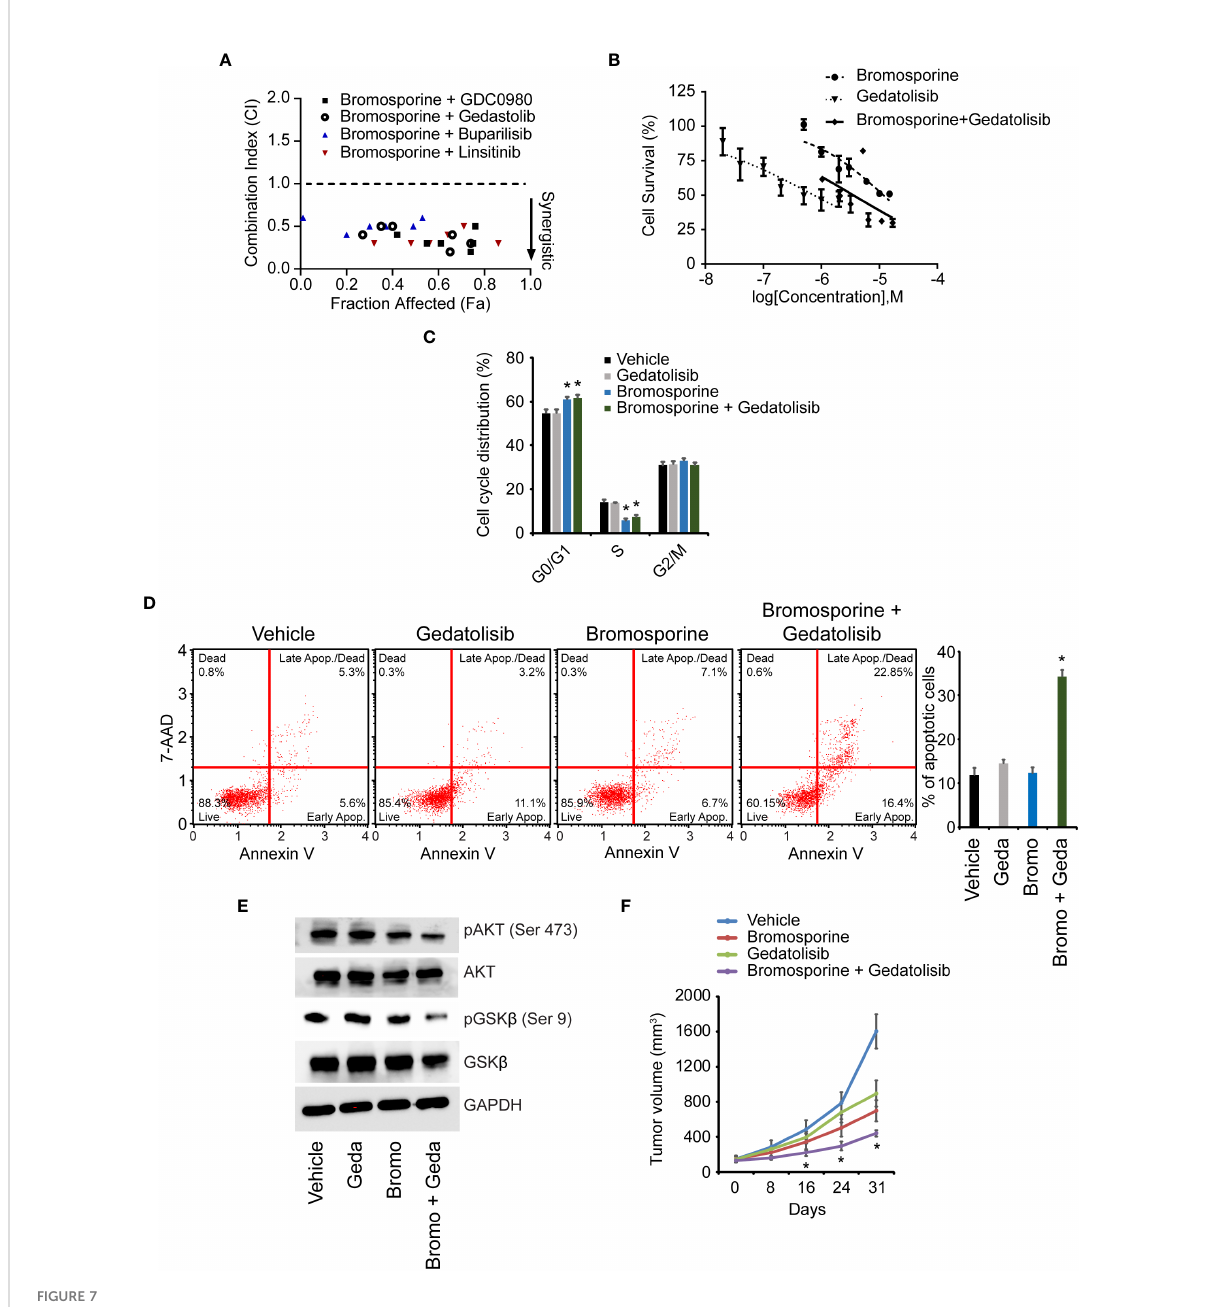
FIGURE 7 Effects of combinatorial therapy with bromosporine and PI3K pathway-targeting agents. (A) Combination index (CI) values for various bromosporine-containing combinations in 231 cells. (B) Effects of treatment with bromosporine and gedatolisib, alone or in combination, on viability of 231 cells. (C) Cell cycle analysis following treatment of 231 cells. (D) Analysis of apoptotic rate after drug treatment of 231 cells based on detection of 7-AAD and Annexin V. (E) Western analysis of expression of different proteins following drug treatment of 231 cells. (F) In vivo growth of 231 tumors following treatment with bromosporine and gedatolisib, alone or in combination. *p <